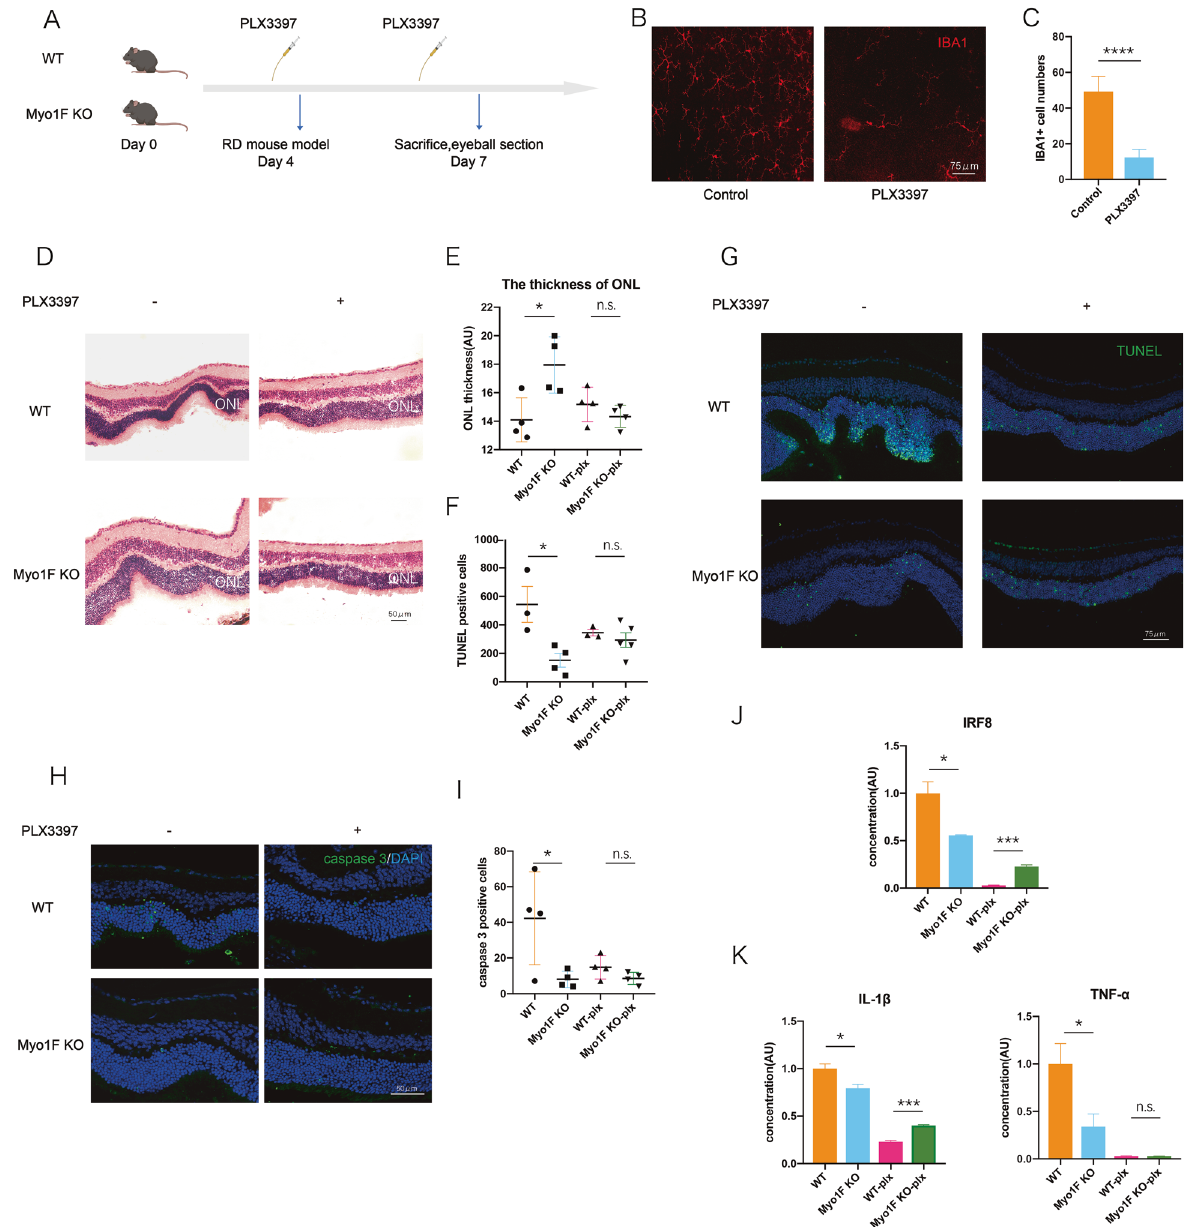
Fig. 5 Elimination of microglia reverses the protective effect of myosin 1f de fi ciency. A PLX3397 was given to WT and myo1f KO mice every day from day 1 to day 6, the mice were sacri fi ced on day 7, 3 days after the mouse model of retinal detachment (day 4). B , C Representative image of fl atmount of the detached retina ( B ) and elimination ef fi cacy ( C ). D , E Representative HE staining showed the thickness of ONL on the detached retina ( D ) (scale bar, 50 μ m) and quanti fi cation of ONL thickness ( E ) ( n = 4). F , G Representative TUNEL staining ( F ) (in green) (3 days after induction of RD) (scale bar, 75 μ m) and quanti fi cation of TUNEL-positive cells in ONL ( F ) among four groups showed apoptosis of photoreceptors after microglia elimination. H , I Representative cleaved caspase 3 staining ( H ) (in green) (3 days after induction of RD) (scale bar, 50 μ m) and quanti fi cation of cleaved caspase 3-positive cells in ONL ( I ) among four groups showed apoptosis of photoreceptors after microglia elimination. J , K qPCR analysis demonstrated the fold change of IRF8, IL-1 β , and TNF- α (day 3). Data were presented as mean ± SEM, unpaired t test, *P < 0.05, **P < 0.01, ***P < 0.001, ****P <